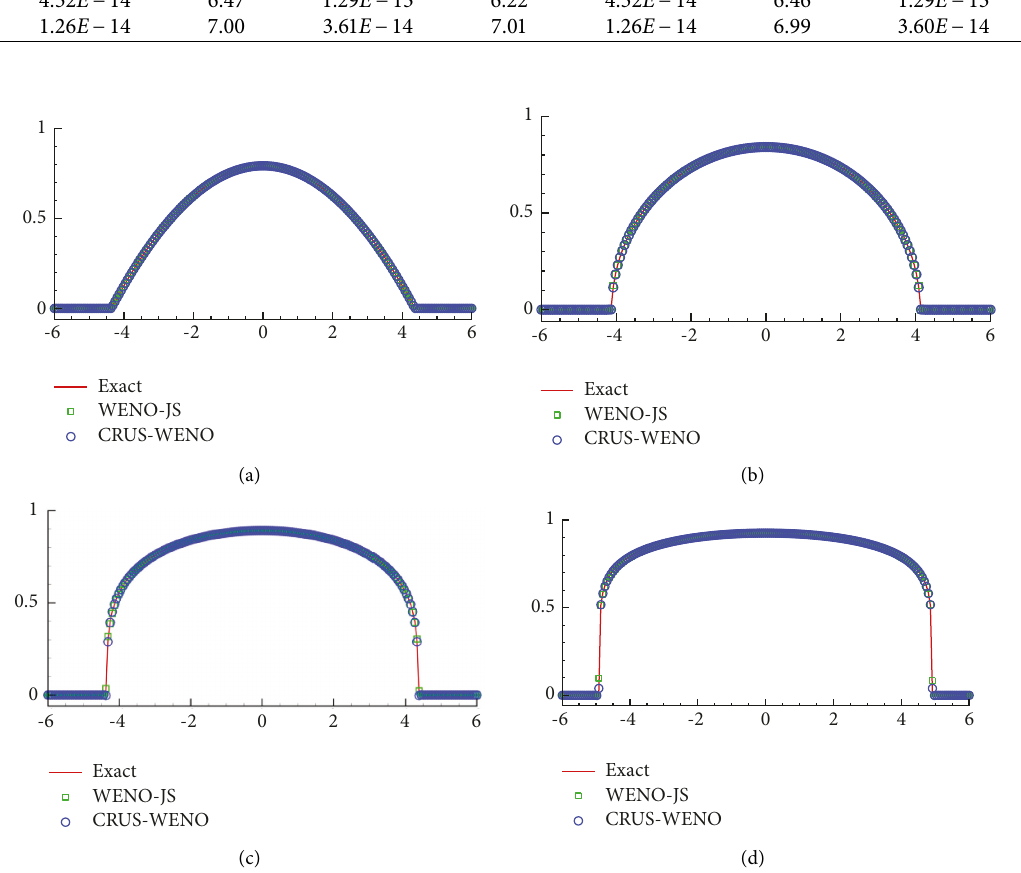
Figure 1: Example 3. Barenblatt solution for PME. T � 2.200 grid points. (a) m � 2, (b) m � 3, (c) m � 5, and (d) m �